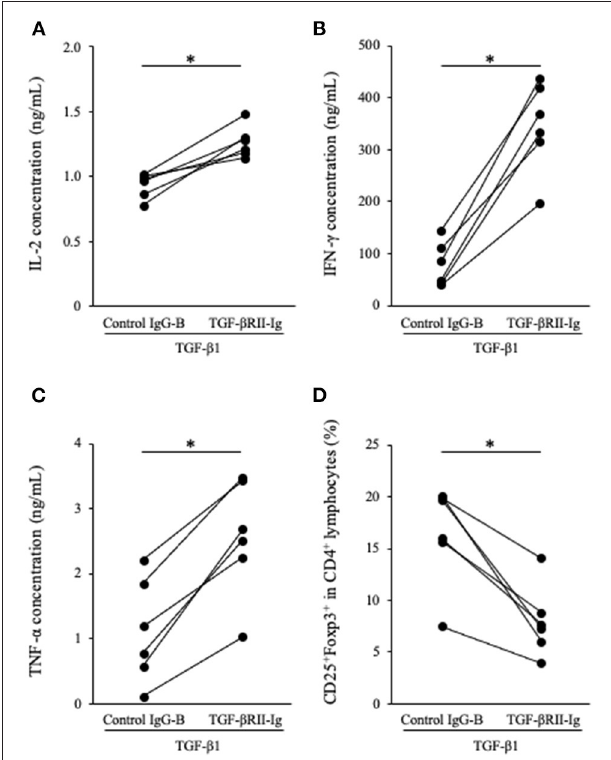
FIGURE 5 | Effect of TGF- β RII-Ig on Th1 cytokine production and Tregs differentiation of in PBMC cultures in the presence of TGF- β 1. (A) IL-2, (B) IFN- γ , and (C) TNF- α in cell culture supernatants were measured by ELISA. (D) The percentage of CD25 + Foxp3 + cells among CD4 + lymphocytes was calculated by flow cytometry. The Wilcoxon signed-rank sum test was used for statistical analysis ( n = 6, * p <